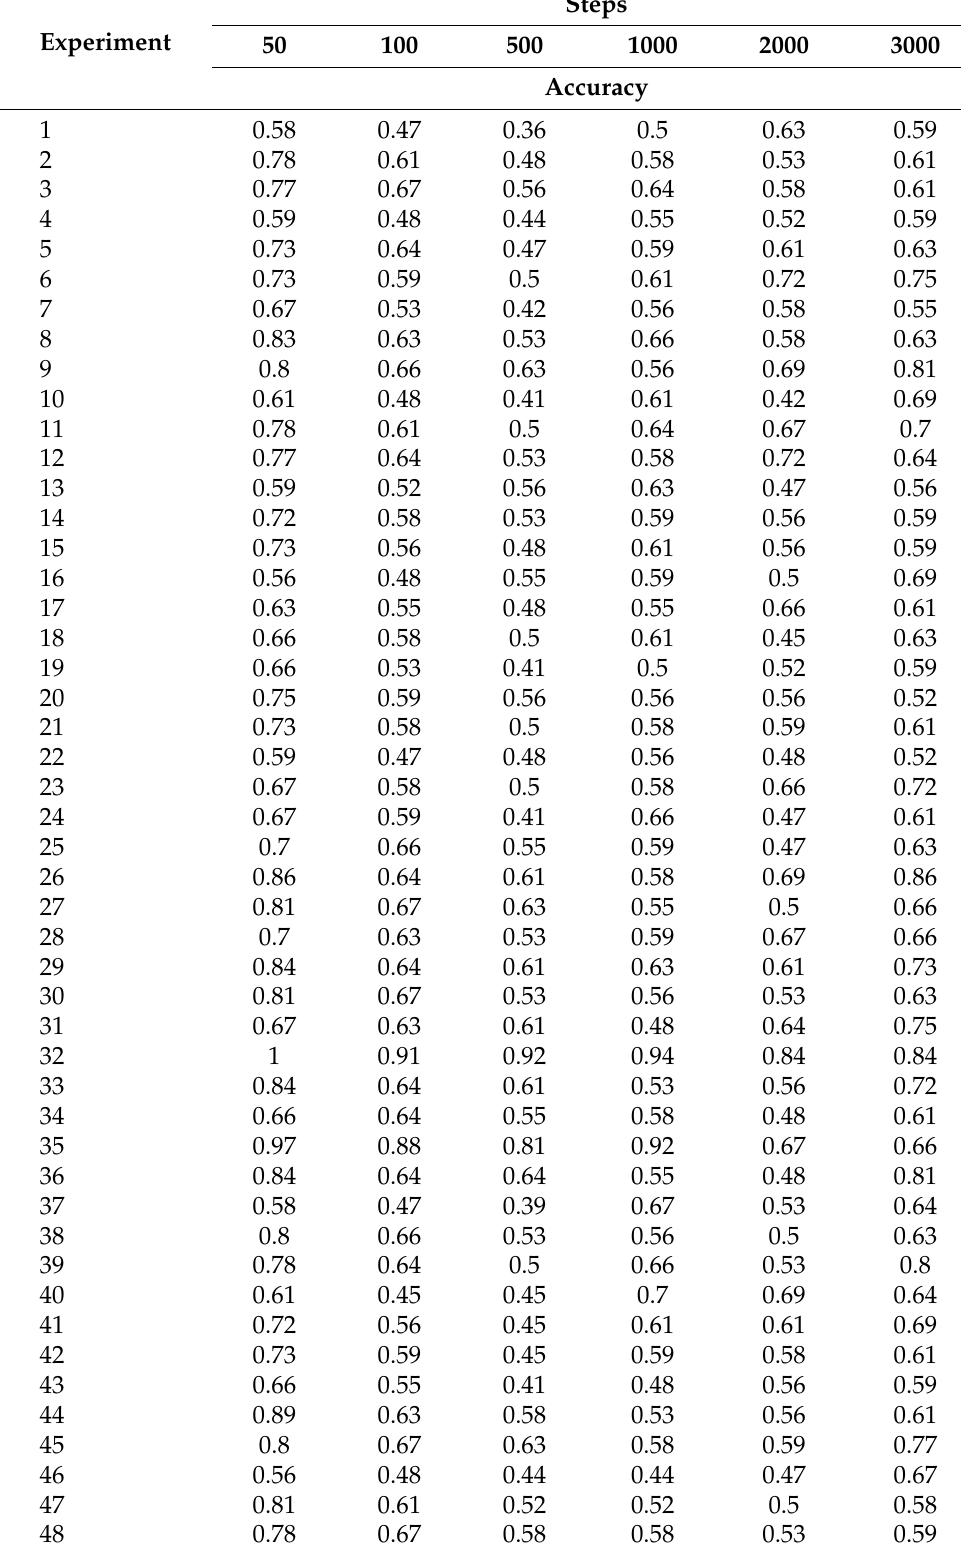
Table 4. Accuracy performance under occupancy